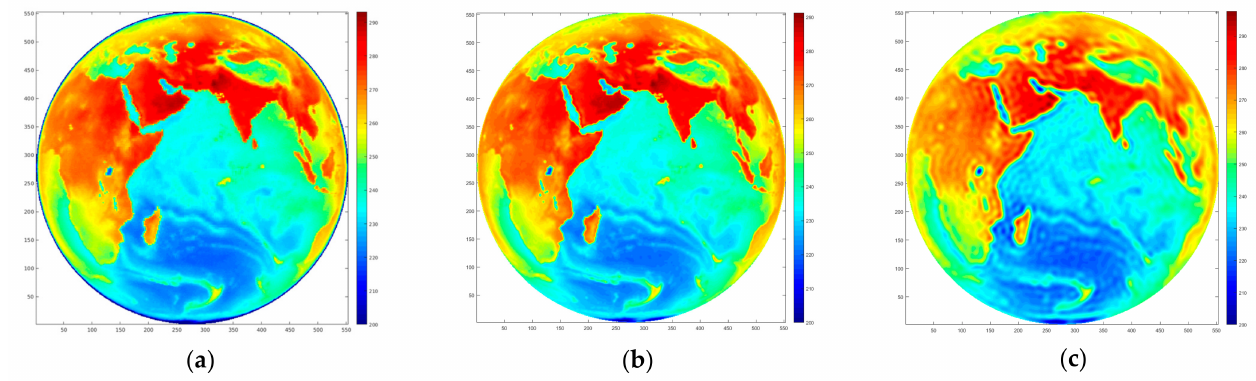
Figure 3. 50.3 GHz simulated brightness temperature map of the full-Earth disk for ( a ) GMR, ( b ) GeoSTAR, and ( c )